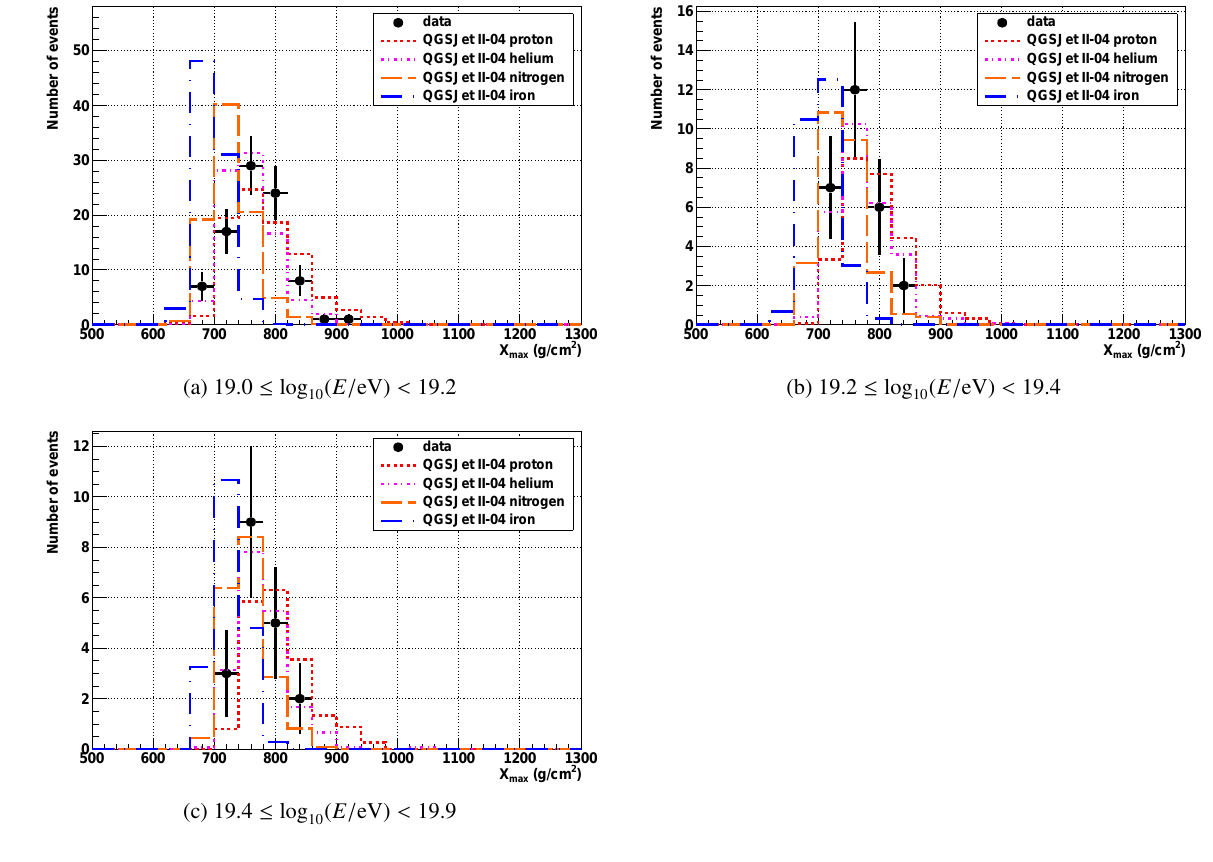
Figure 10: BR / LR hybrid X max distributions